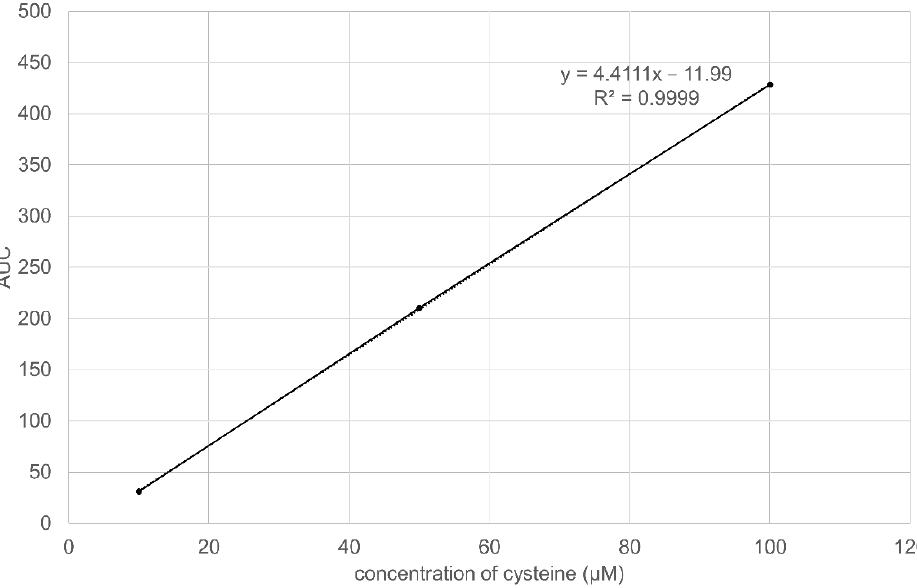
Figure A8. Calibration curve to determine the amount of cysteine in rat small intestine.